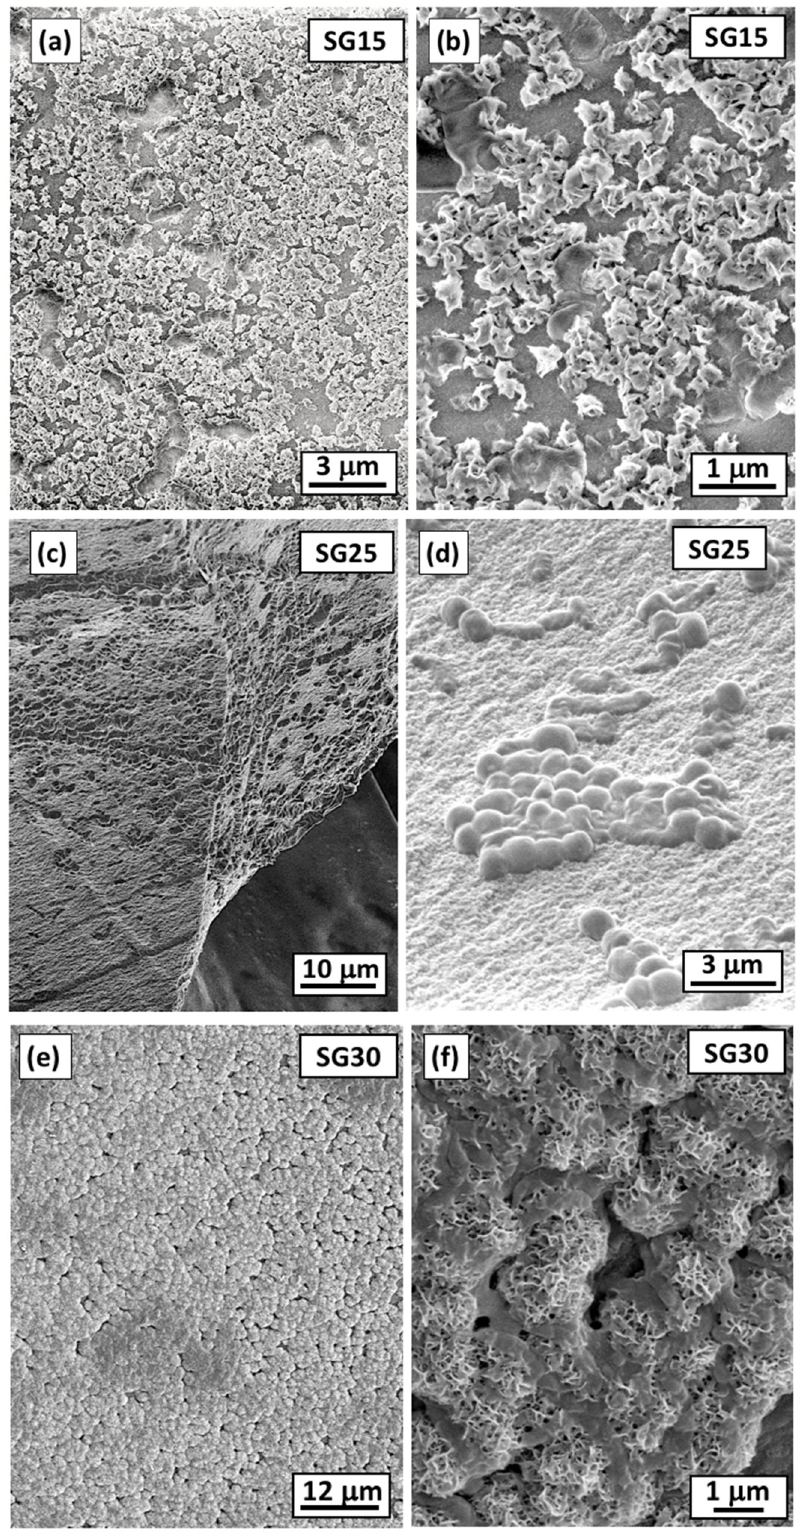
Figure 7. SEM micrographs of the surfaces of ( a , b ) SG15, ( c , d ) SG25, and ( e , f ) SG30 aerogels after soaking in SBF for 21 days at 37 °C exhibiting a bioactive response through the formation of a hydroxyapatite (HAp) layer at different stages of crystal growth.